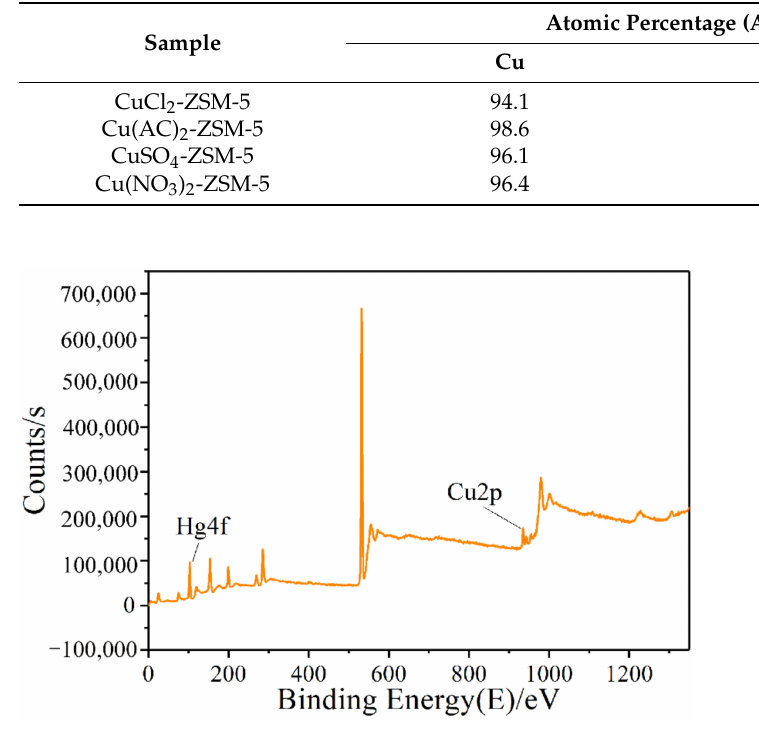
Figure 5. XPS full spectrum of 2.5% CuCl 2